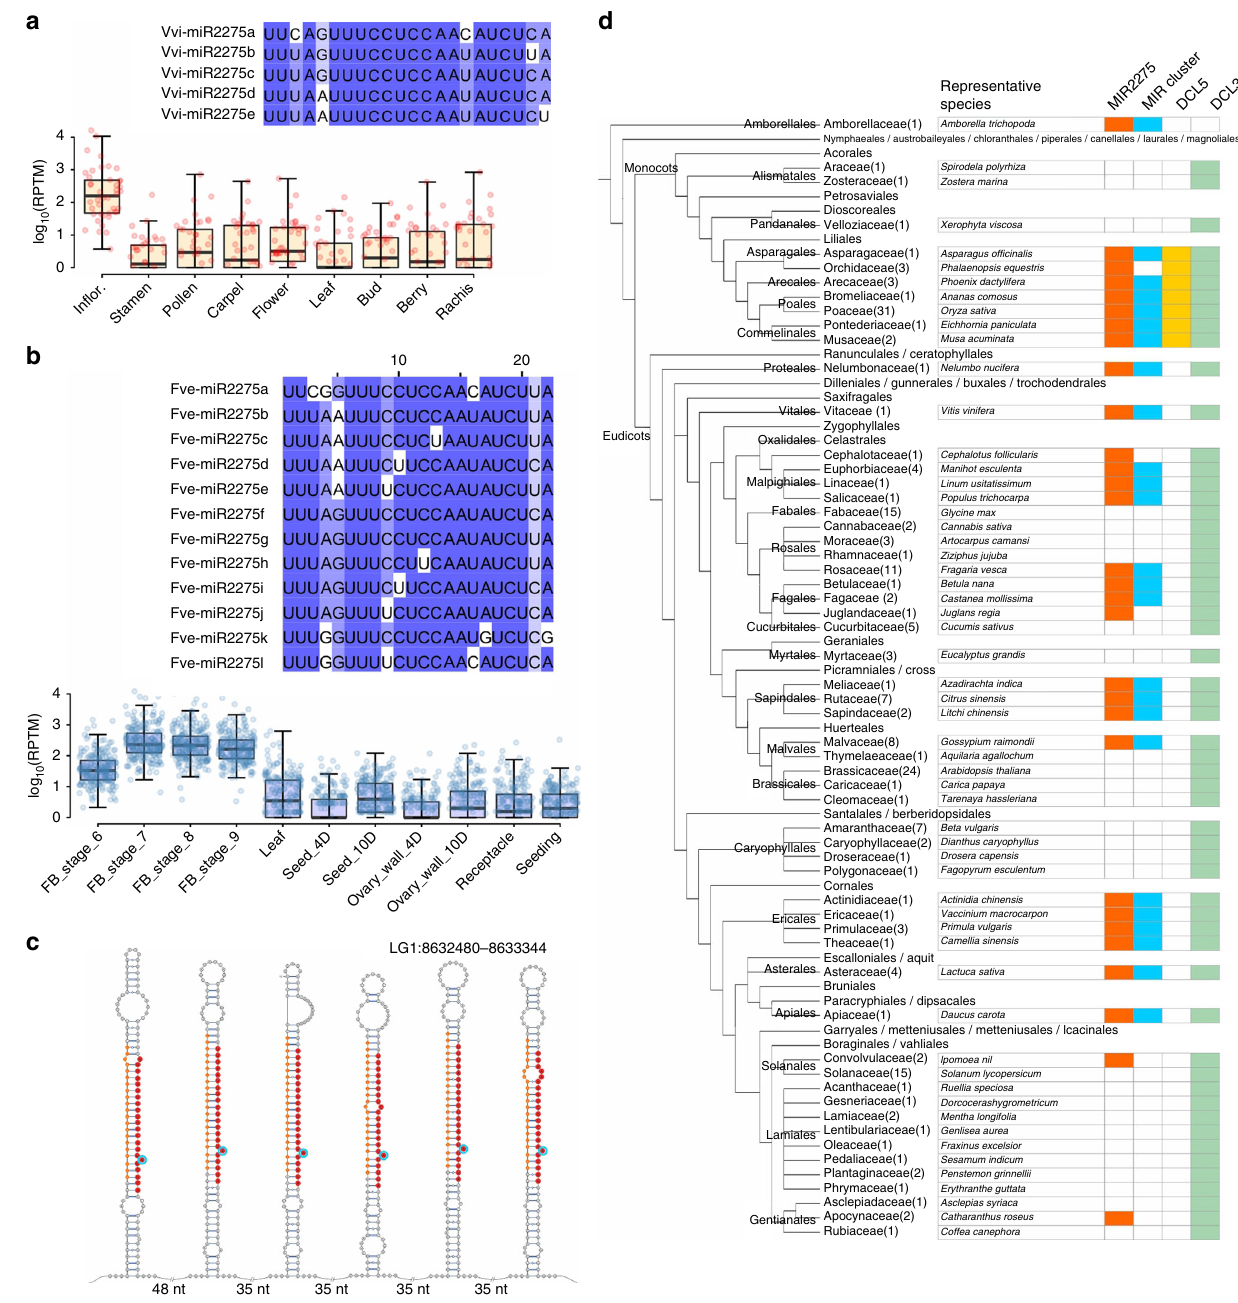
Fig. 3 Wide conservation of the miR2275/24-nt phasiRNA pathway in eudicots. a miR2275 diversity and 24-nt phasiRNA accumulation in grape. Above: the degree of sequence conservation along the miRNAs is represented by the density of blue color. Below: summed abundances of sRNAs at each of 42 24- PHAS loci in reads per ten million (RPTM). In the boxplot, the center line represents the median; box limits are the upper and lower quartiles; whiskers are the 1.5× interquartile range; points show the scatter of data points. b miR2275 diversity and 24-nt phasiRNA accumulation in strawberry, as in panel a , but for 221 24- PHAS loci. The boxplot is drawn as in panel a . c A polycistronic precursor encoding six MIR2275 stem – loops in strawberry, with miR2275 and miR2275* marked in red and orange, respectively. Bulges within the miR2275/miR2275* duplexes are indicated by a cyan circle. d A tree illustration of the conservation of the miR2275/24-nt phasiRNA pathway in plants. The plant phylogeny (left) was constructed according to the NCBI Taxonomy Common Tree. Plant orders or families denote representative plant species in a given order or family with genome sequenced and encoding miR2275 in the genome (black), with genome sequence but no miR2275 found (blue), and no genome sequenced (light gray). Numbers in parentheses after the family name indicate the number of plant species of that family used in this study. The presence of a given element (miR2275, DCL5 , DCL3 ) or feature ( MIR2275 in a polycistronic cluster) is indicated by colored